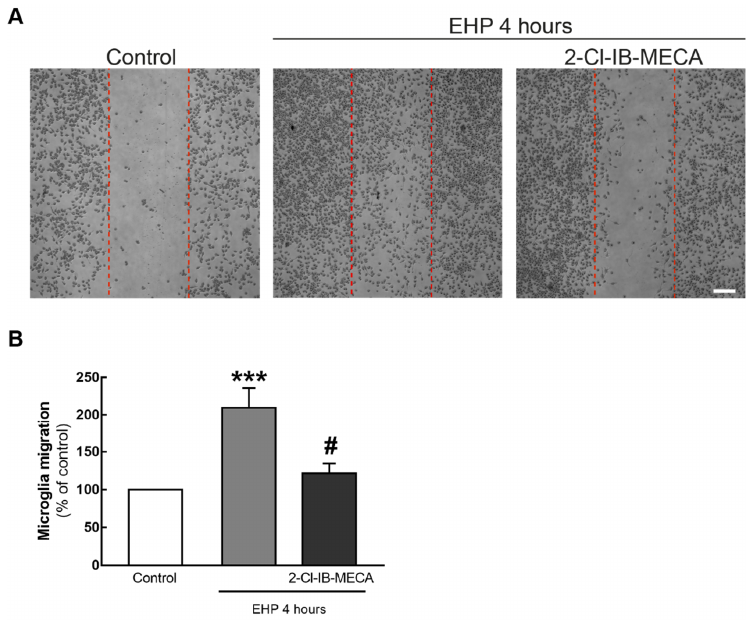
Figure 3. Effect of A 3 R activation in EHP-induced BV-2 cell motility. Cells were pre-treated with 1 µM 2-Cl-IB-MECA followed the exposure to EHP for 4 h. ( A ) Representative images of the cultures at the beginning and at the end of the experiment are depicted. The vertical dotted red lines mark the initial wound. Scale bar: 200 µm. ( B ) The number of cells in the wound was counted per field, and the results were expressed in percentage of control from 9–10 independent experiments. *** p < 0.001 compared with control, # p < 0.05 compared with EHP, one-way ANOVA test, followed by Holm–Sidak’s multiple comparisons test. Int. J. Mol. Sci. 2020 , 21 , x FOR PEER REVIEW